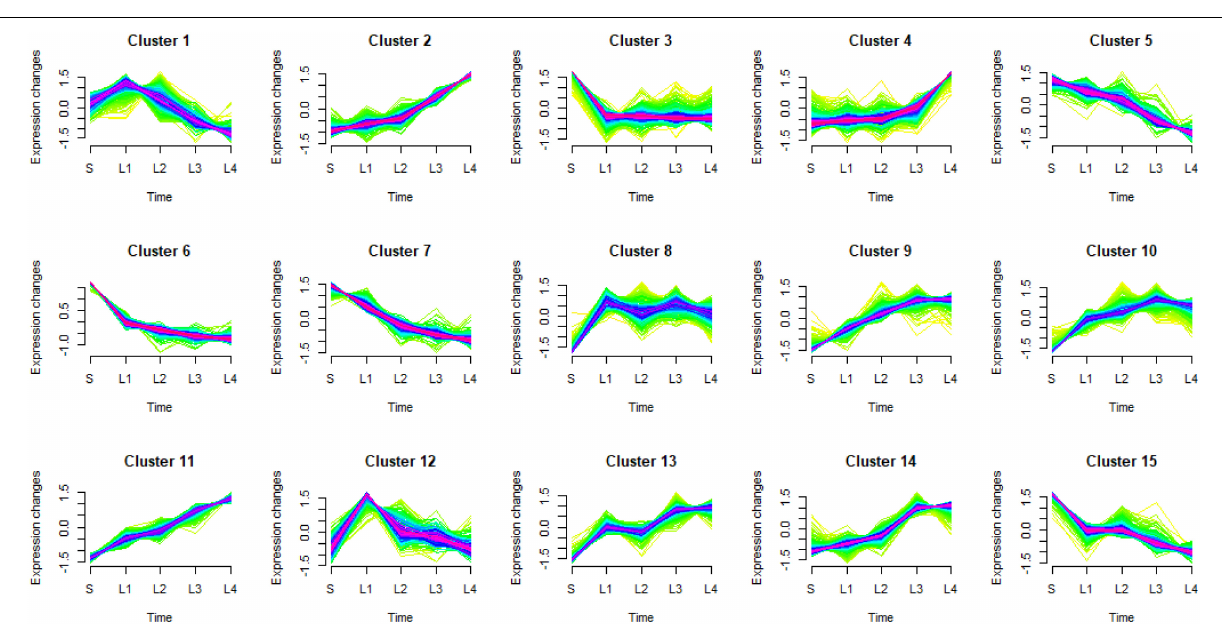
2, with the LOB (6) as the top abundant family ( Figure 8A ).